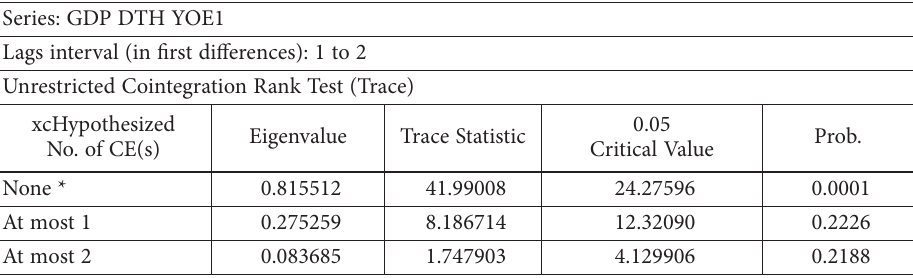
Table 7. Johansen Cointegration Test for Cluster